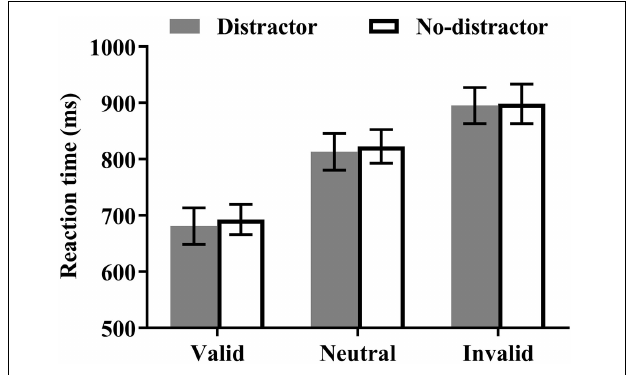
FIGURE 3 | Mean reaction times ( ± SE) as a function of cue type and distractor.